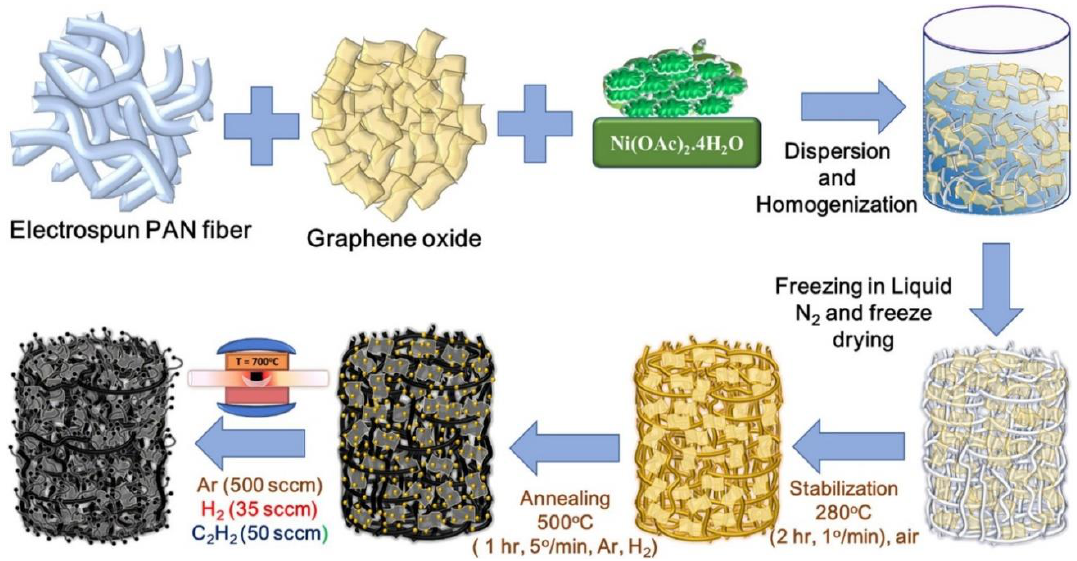
Figure 9. Schematic of making graphene and nanotube containing composite carbon nanofiber aerogel. Reprinted with permission from [38]. Copyright © 2019 Elsevier B.V.